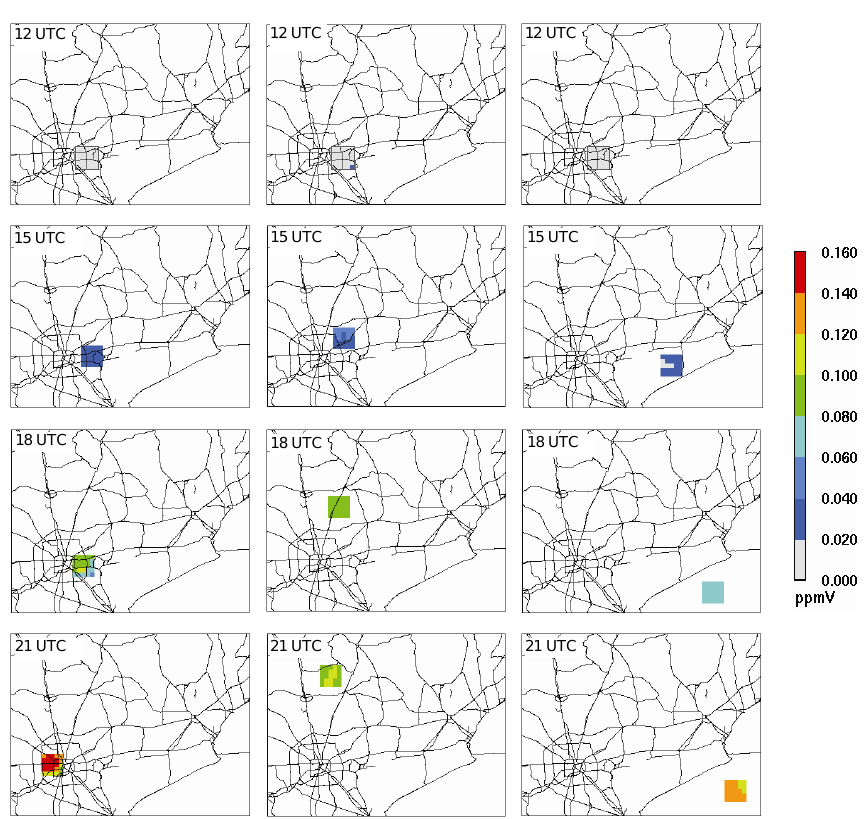
Figure 6. Snapshots of ozone mixing ratios as simulated by STOPS along trajectories on 25 (left), 28 (middle), and 30 August (right) when the STOPS simulation started from the industrial sub-domain. Table 6. Statistical parameters for simulations with different STOPS domain sizes, where only nine inner cells were chosen for the analysis. The results correspond to the moving case, when the trajectory starting position corresponds to the 21 and 30 CMAQ column and row,